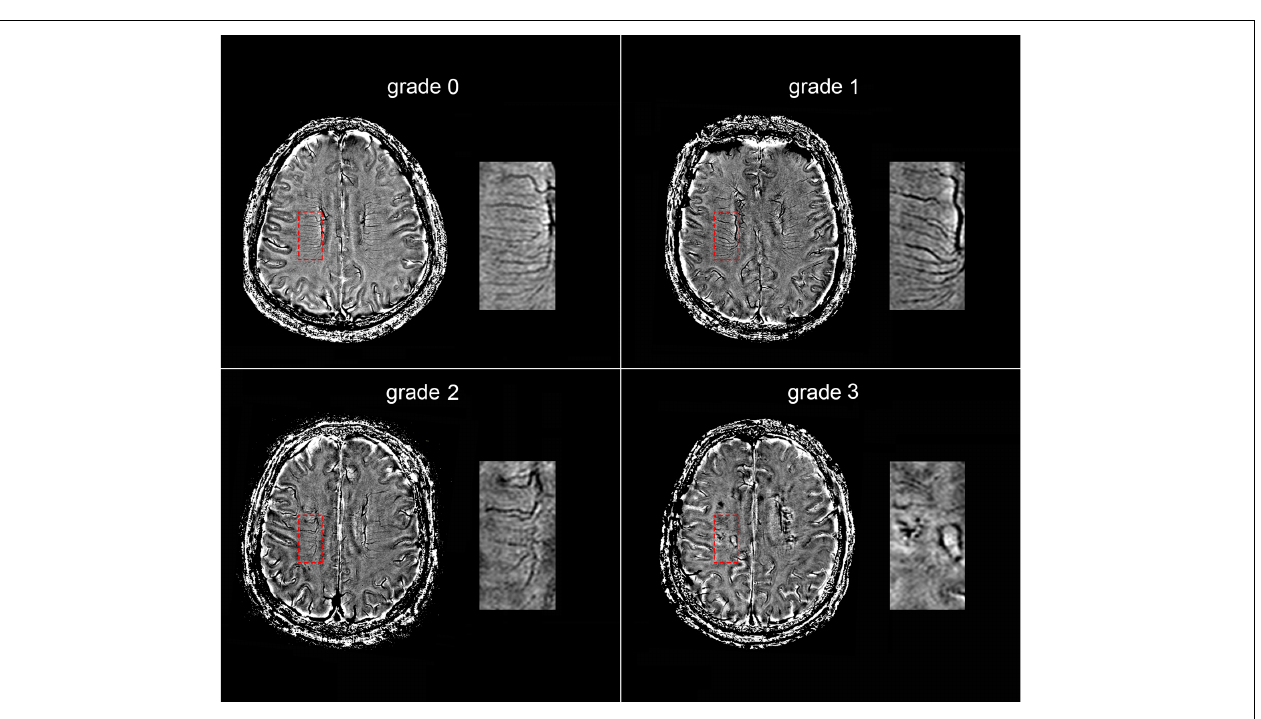
FIGURE 2 | Deep medullary veins (DMVs) visual scores. An example of four-point DMVs score in parietal region: Grade 0 – each vein was continuous and had homogeneous signal; Grade 1 – each vein was continuous, but one or more than one vein had inhomogeneous signal; Grade 2 – one or more than one vein were not continuous, presented with spot-like hypointensity; Grade 3 – No observed vein was found